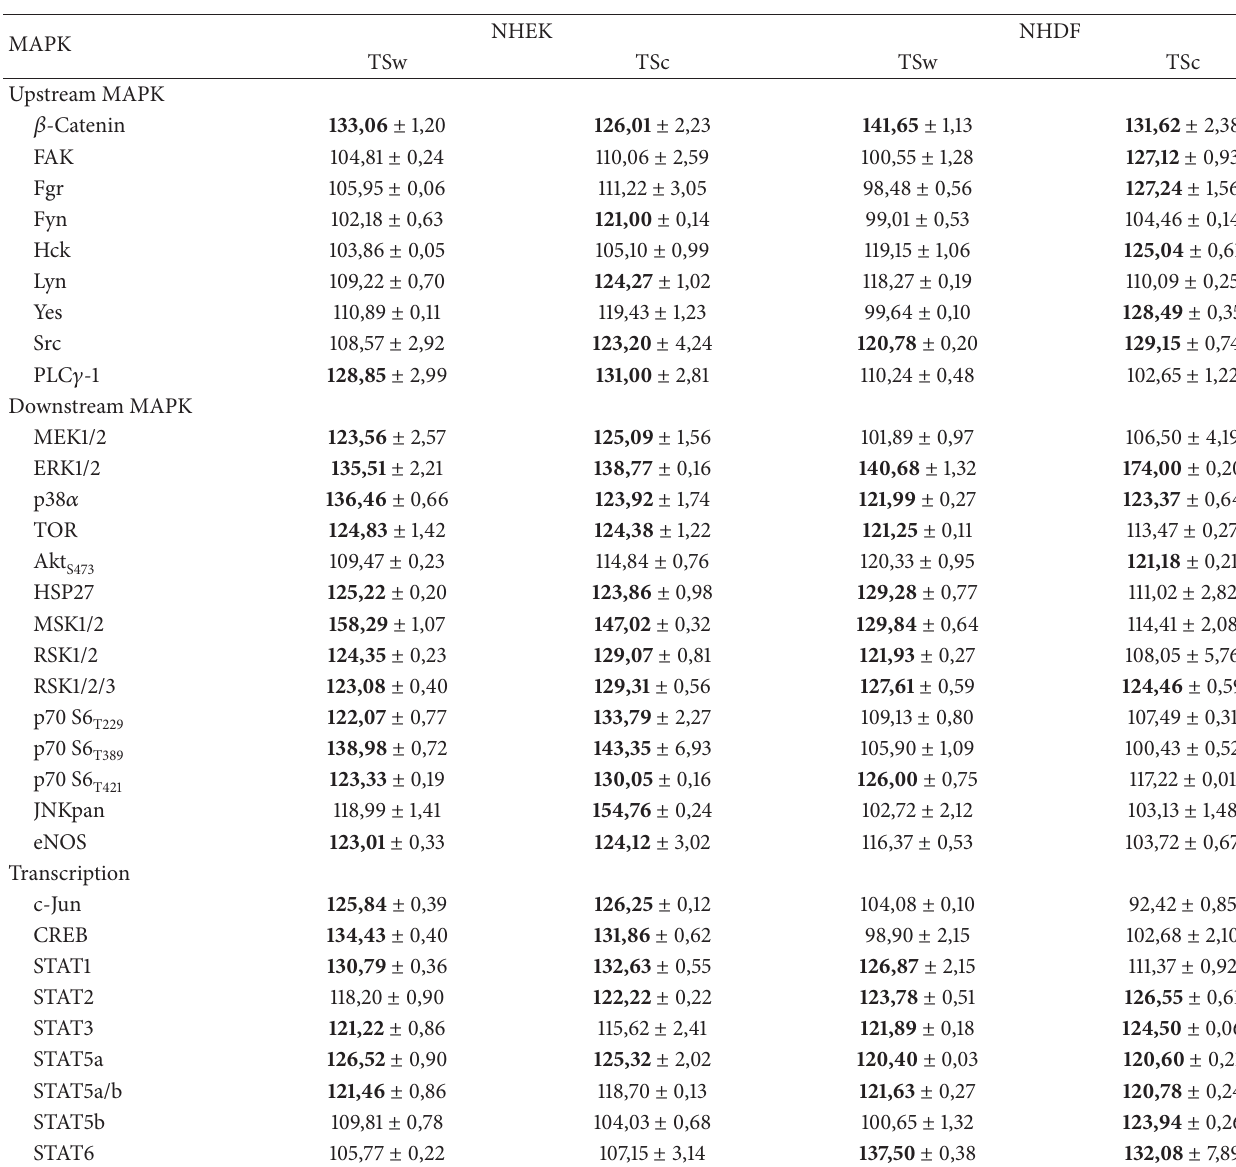
Table 4: Relative protein phosphorylation levels related to untreated cells after treatment of NHEK and NHDF with 10mg/mL TSw and TSc for6hmeasuredwiththeProteomeProfilerHumanPhospho-KinaseArraykit.Anincreaseordecreaseof >